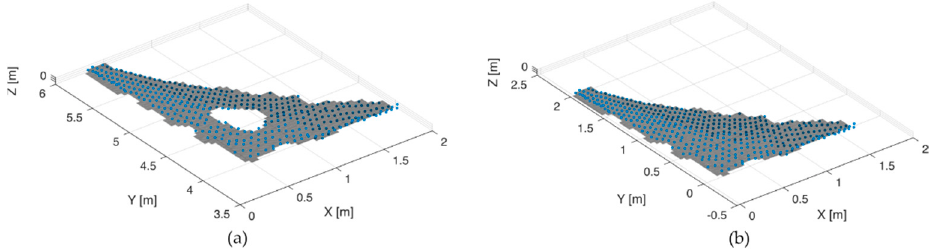
Figure 21. Planar surface visualization: ( a ) Point cloud with a hole; ( b ) Normal surface.